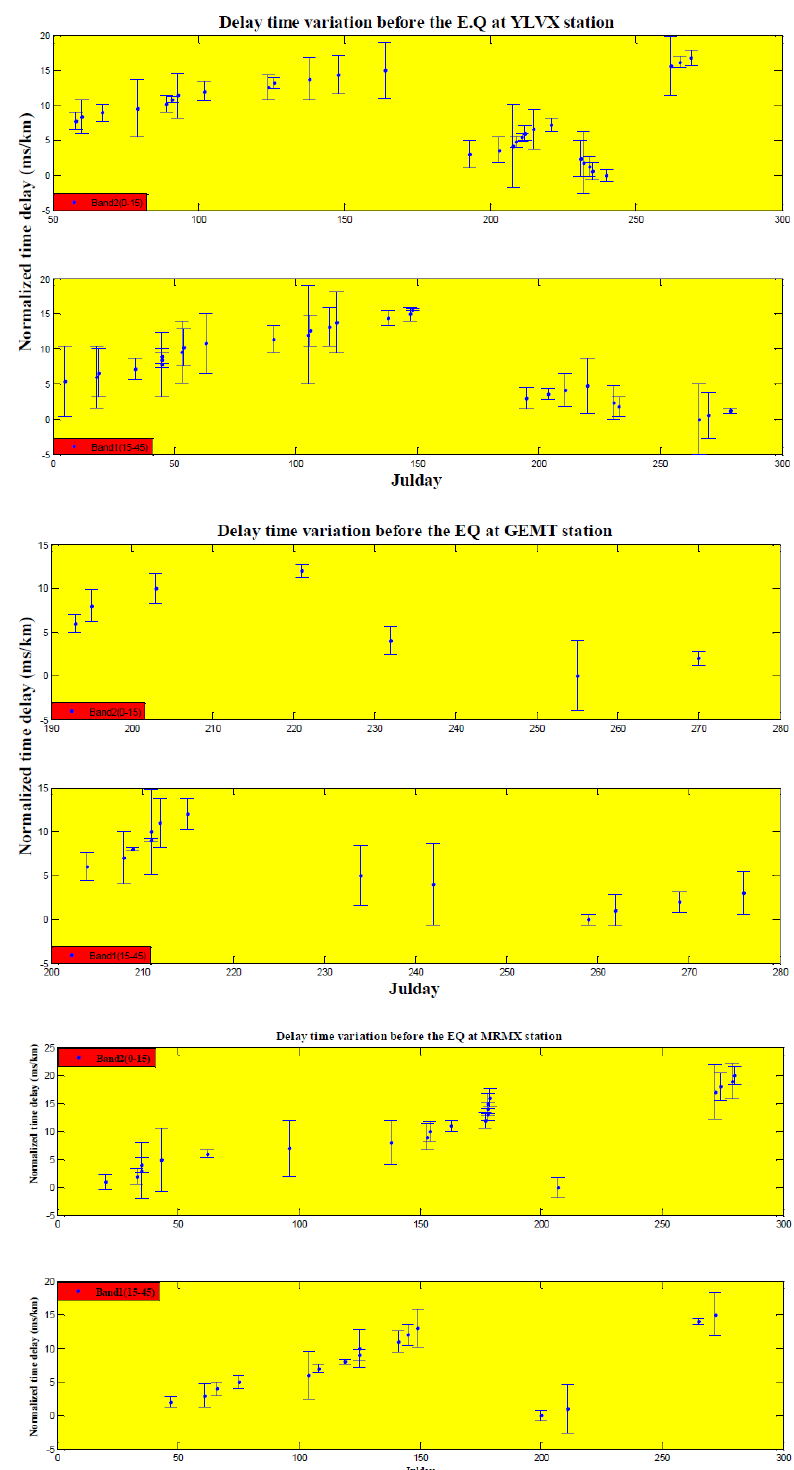
Fig. 8. (a) Variations of time-delays between split shear waves for 1 January 2006 to 19 October 2006 at station YLVX. (b) Variations of time-delays between split shear waves for 1 January 2006 to 19 October 2006 at station GEMT. (c) Variations of time-delays between split shear waves for 1 January 2006 to 19 October 2006 at station